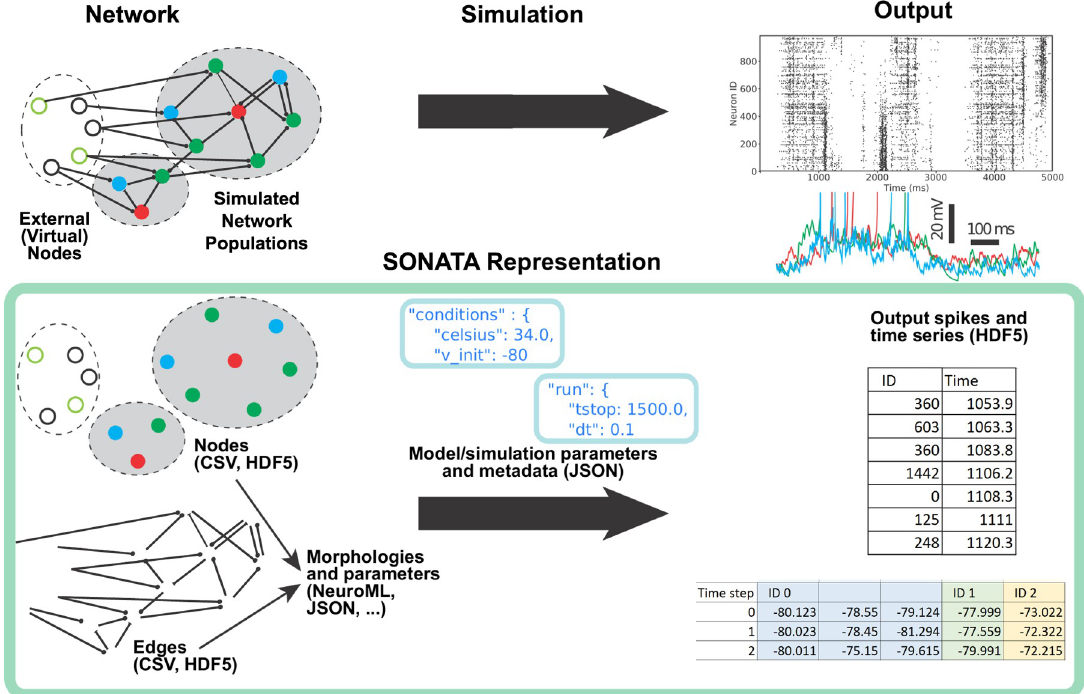
Fig 1. Overview of the SONATA data format. (Top) A simulated model consists of one or more explicitly simulated network populations and external sources (virtual nodes) that provide inputs into the simulated populations. During and after simulation (by a simulation platform which supports SONATA), output is created characterizing dynamics in the simulated model. (Bottom) The SONATA data format reflects the major components of simulation in dedicated file structures. Information about the model is stored in files (CSV and HDF5) describing nodes and edges of the network (left). Model metadata (e.g., path relations between files on disk) and information about simulation are stored in JSON configuration files (middle), which are used to pass network files to the simulator (network files are generated by model building software supporting SONATA, such as BMTK, PyNN, or NetPyNE; see below in Ecosystem support ). The spiking and time series output is stored in a tabular format, taking advantage of the HDF5 technology (right). In the case of time series (bottom right), multiple variables can be stored for individual nodes (in this example, node ID 0 has three variables stored), which can correspond, e.g., to multiple compartments of a neuron.